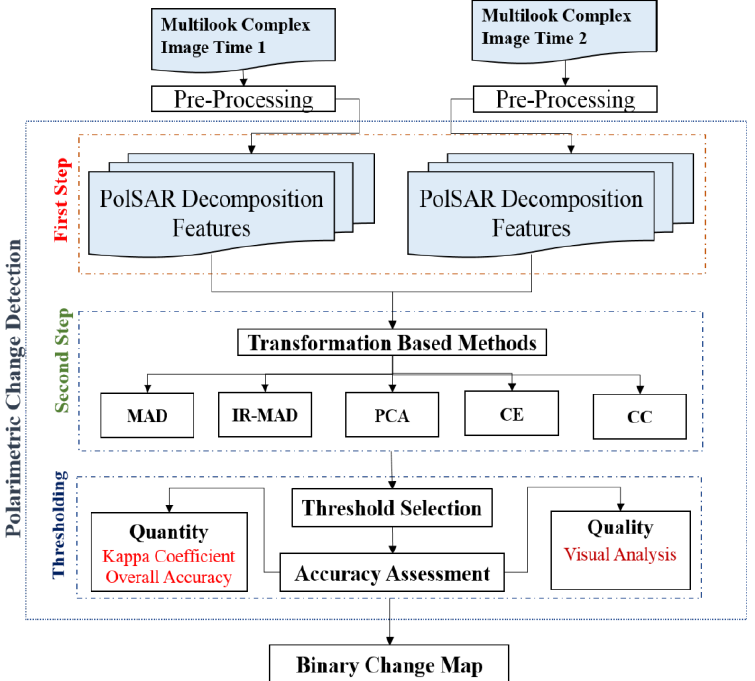
Figure 1. Flowchart Polarimetric Change Detection Based on Transformation Based